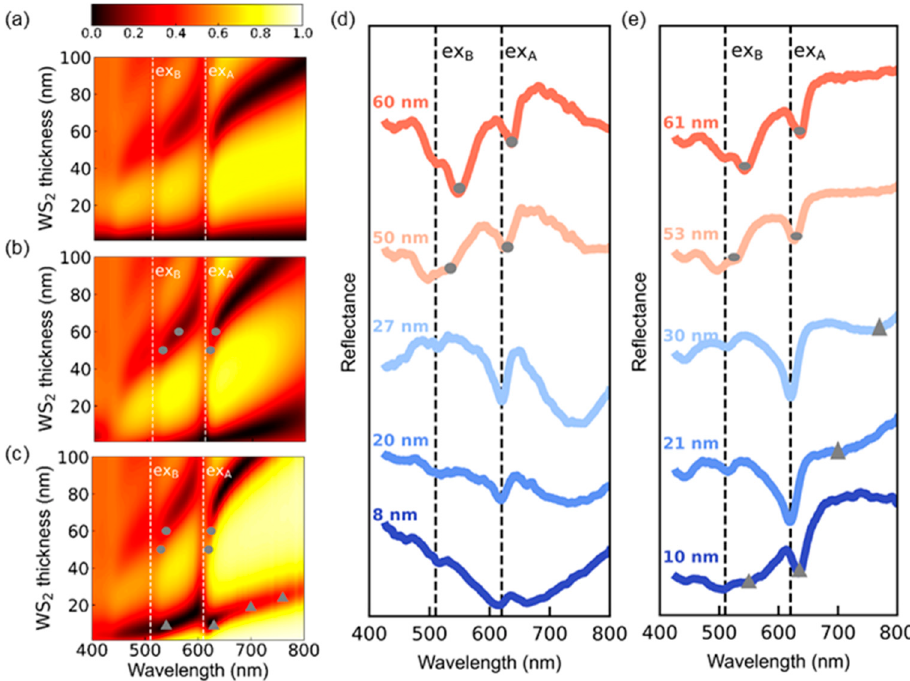
Figure 2. ( a ) TMM-calculated thickness-dependent reflectance spectra of ( a ) stand-alone WS 2 (air/WS 2 /air), ( b ) WS 2 /SiO 2 /Si, and ( c ) WS 2 /Au. Measured reflectance spectra of WS 2 flakes with various thicknesses on ( d ) SiO 2 /Si substrates and ( e ) Au thin films. The exciton resonance wavelengths of WS 2 are denoted as dashed lines in a–e. Gray circles and triangles in b–e represent the EP-induced dips.